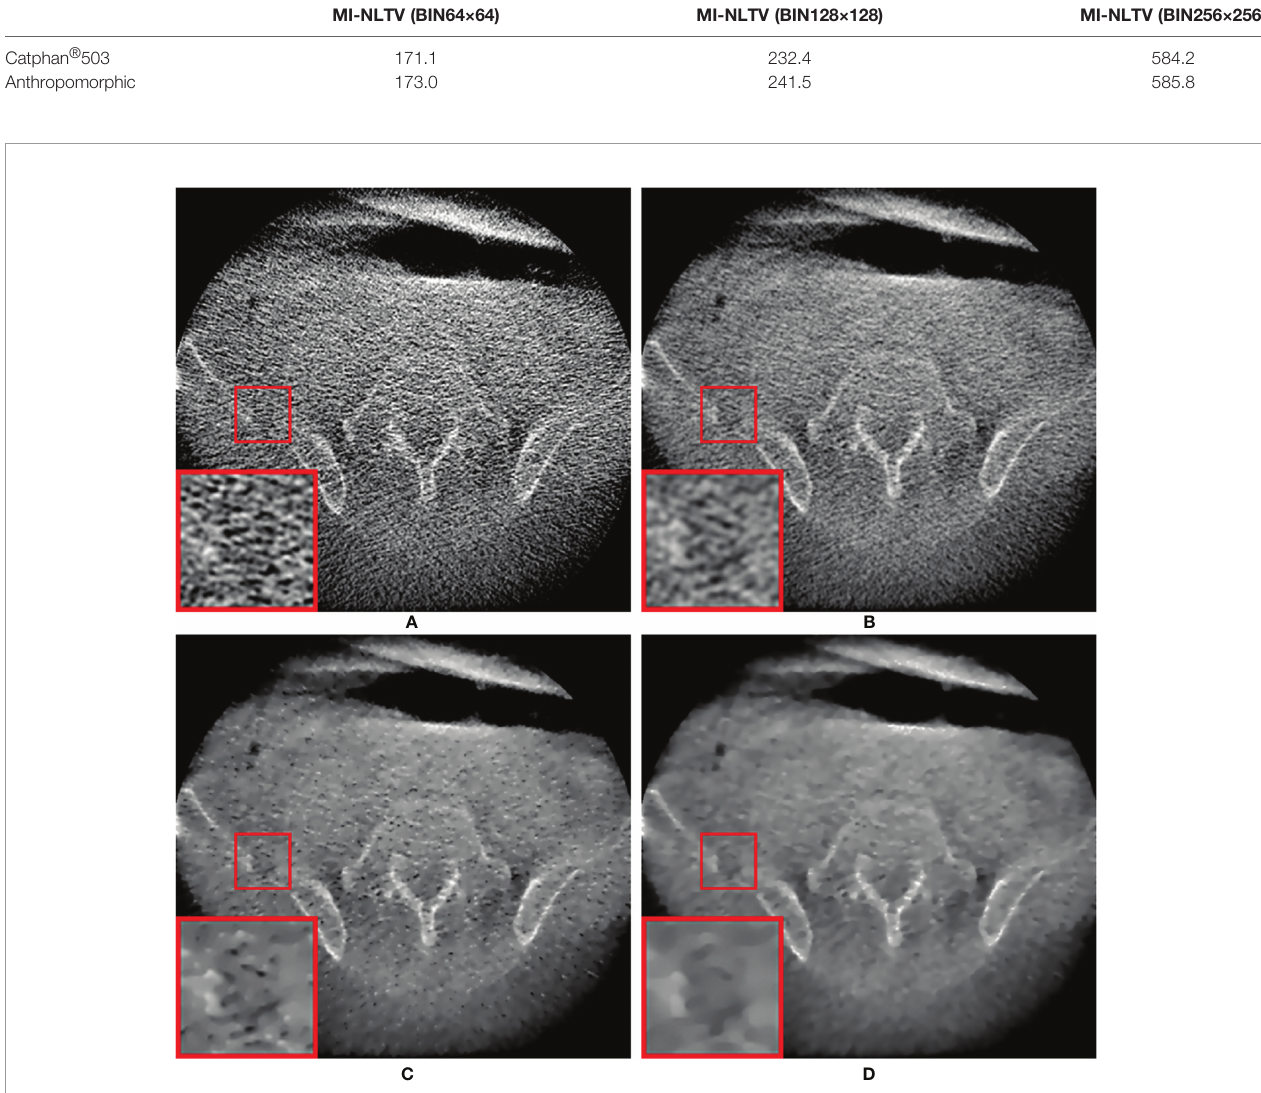
FIGURE 8 | Comparison between the same views of CBCT images generated by applying the analytical reconstruction algorithm based on (A) PDB, (B) RDB, (C) RDB followed by NLTV, and (D) RDB followed by MI-NLTV using a patient data with the pelvic bone metastatic lesion. These CBCT images are displayed at the window settings of (width = 2,400, level = 400)